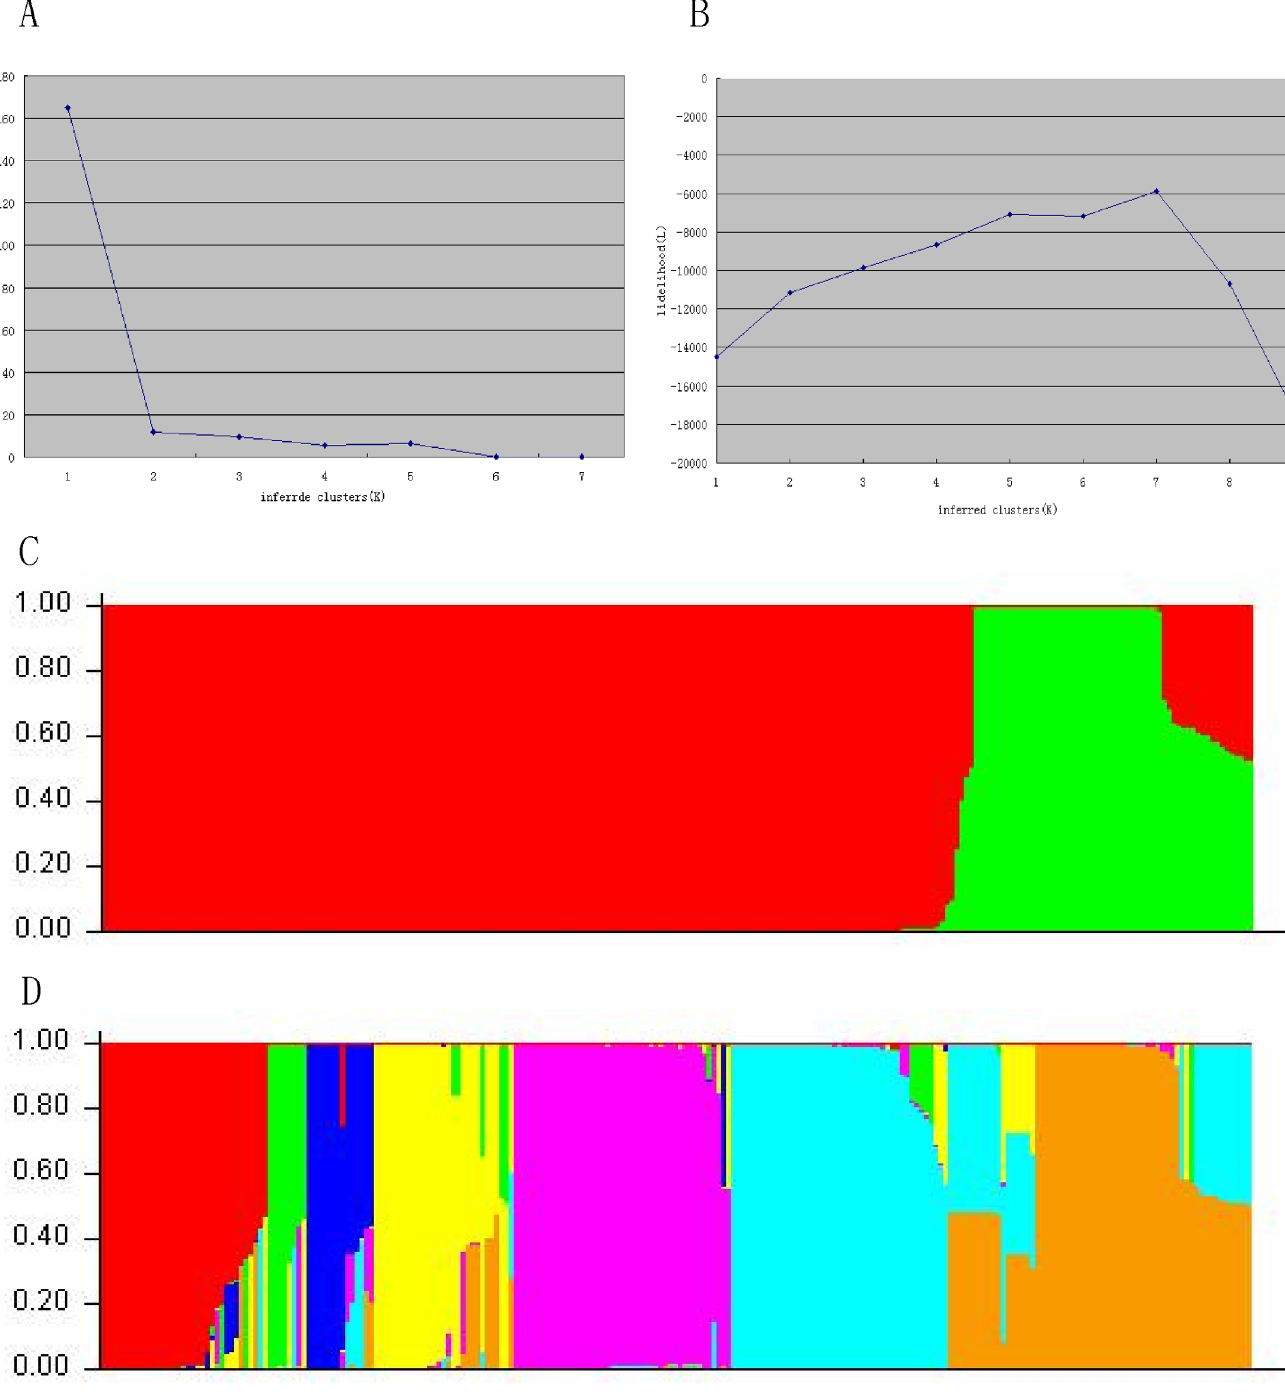
PLOS ONE | DOI:10.1371/journal.pone.0137088 September 1,